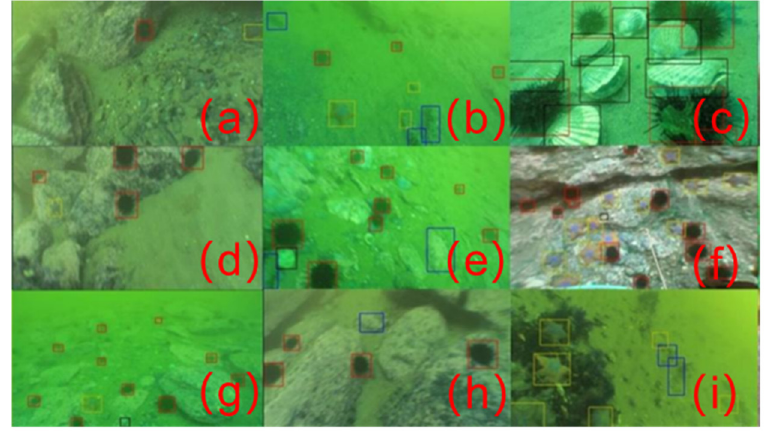
Figure 7. The detection effect of the algorithm in the underwater scene. ( a – i ) represent nine different underwater scene detection effects.